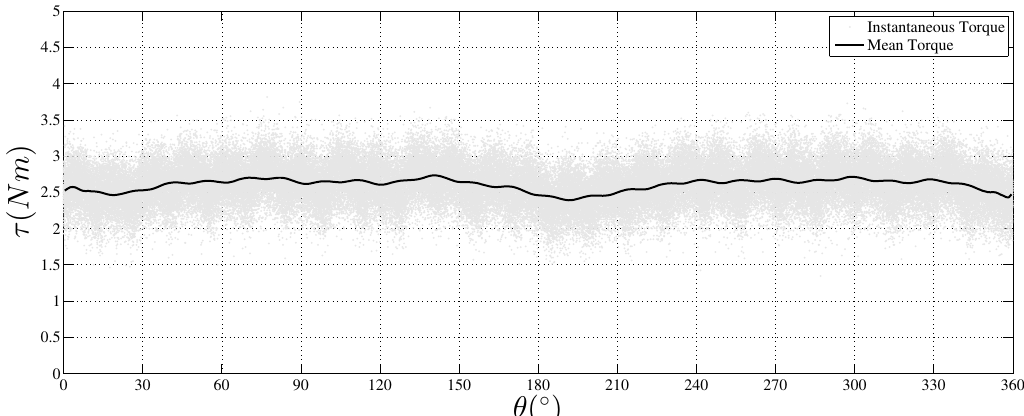
Figure 10. Instantaneous torque (light gray dots) measurements, τ i vs. instantaneous rotor blade angular position, θ i ( ◦ ) . Solid black line illustrates mean torque value, ¯ τ vs. rotor blade angular position, θ ( ◦ ) . Measurements collected from right rotor while turbine was operating at ω = 3.4 rps ( λ ≈ 5.1). RM1 blades are offset 180 ◦ on each rotor but were counter-rotating in